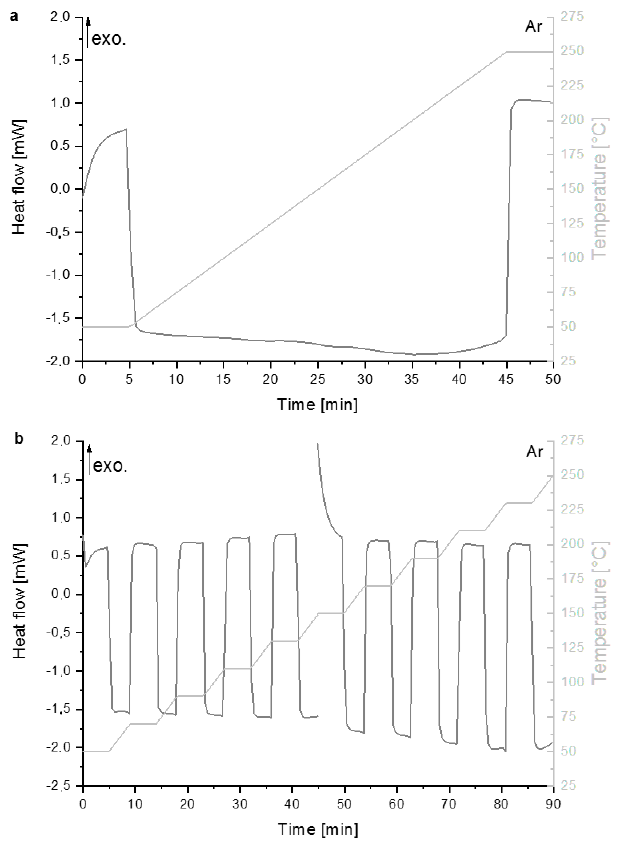
Figure 3. Temperature and heat flow in the range between 50 °C and 250 °C for 2 LiH + MgB 2 in Ar atmosphere using the “linear temperature ramp” method at 5 °C min − 1 ( a ) and the “enthalpy method” ( b ).